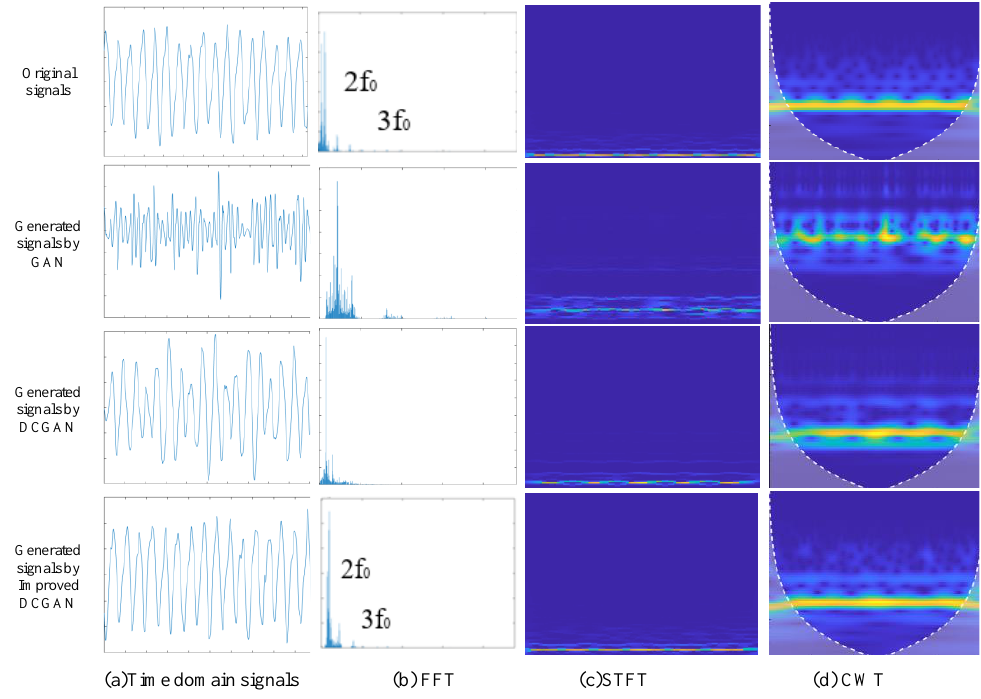
Figure 17. Signal comparison of time domain and frequency domain of the original signals and the generated signals in misalignment state.